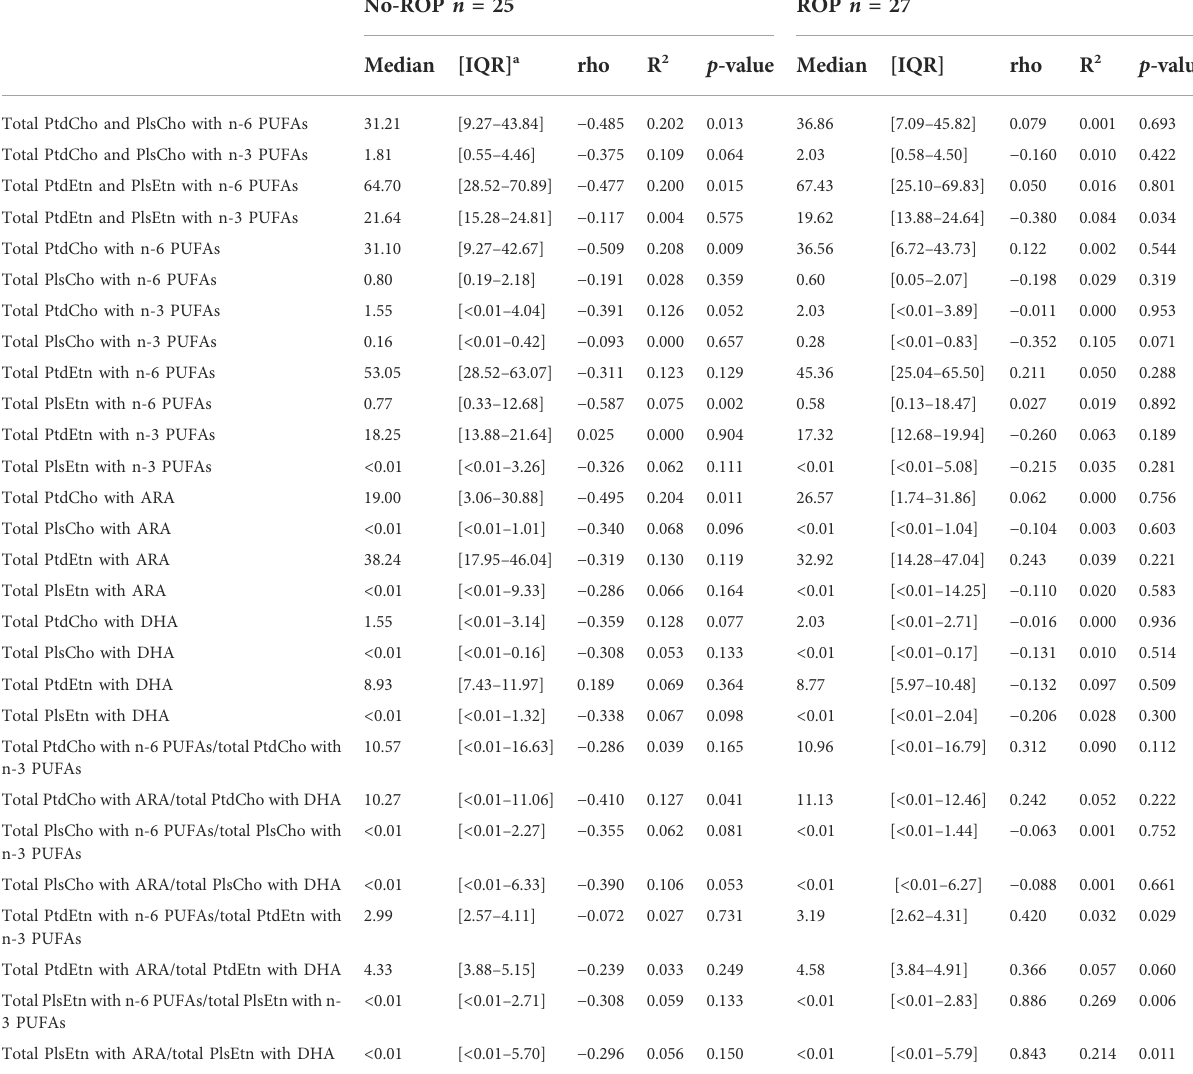
TABLE 2Spearman correlations between gestationalageanderythrocyteChoGplandEtnGplesteri fi edwithn-6 and/orn-3PUFAs inpreterminfants with or without retinopathy of